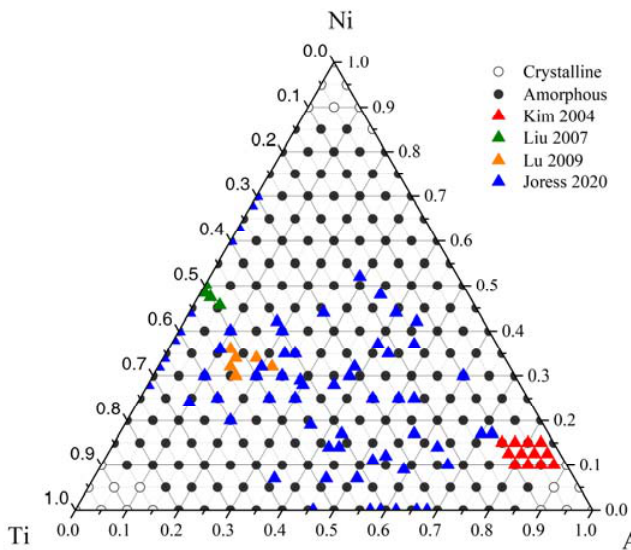
Figure 3. Crystal-amorphous phase diagram of the Al-Ni-Ti system derived from MD simulations at 300 K. Solid and hollow circles represent predicted states. Colored triangles represent experimental data from Kim [52], Liu [53], Lu [54] and Joress [15].